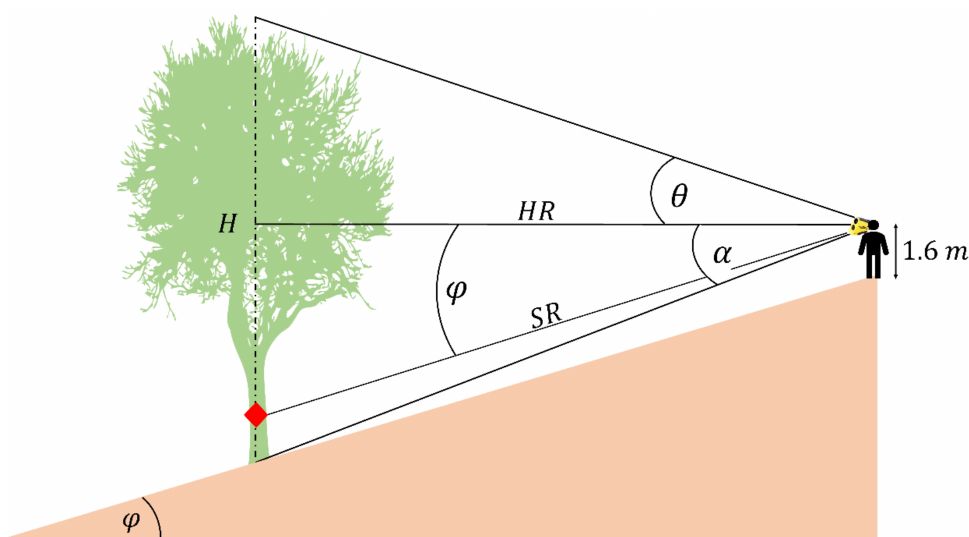
Figure 3. Reference framework involved during hypsometer survey. H is the tree height above- ground; ϕ is the terrain slope measured by pointing the rangefinder to the reflecting pole near the trunk (red rhomb); SR is the slant range (tree-operator distance) and HR is the horizontal distance; and θ and α are the angles measured by tilt sensor (digital clinometer) collimating tree top and tree bottom, respectively. For this work, operator height is fixed at 1.6